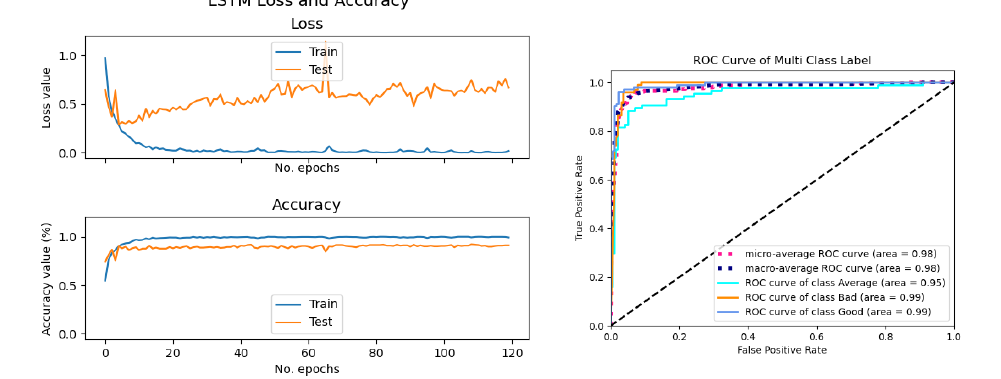
Figure 13. Exp2 (LSTM Accuracy and Loss) and ROC